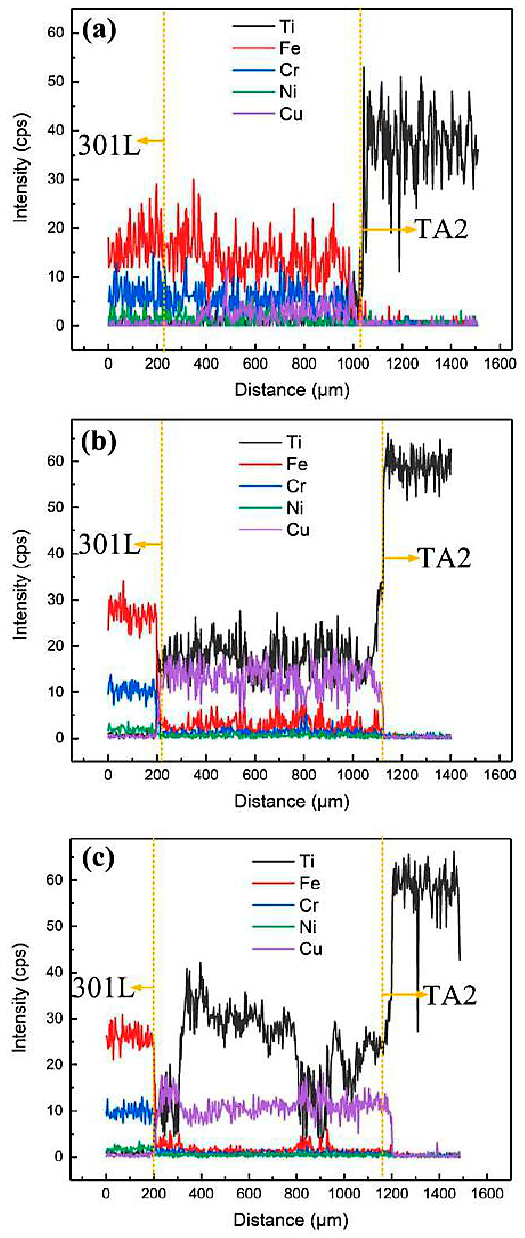
Figure 16. Line scanning results of element for 301L/Cu/TA2 welded joints with various laser offsets: ( a ) offset of − 0.3 mm; ( b ) offset of 0 mm; ( c ) offset of +0.3 mm.